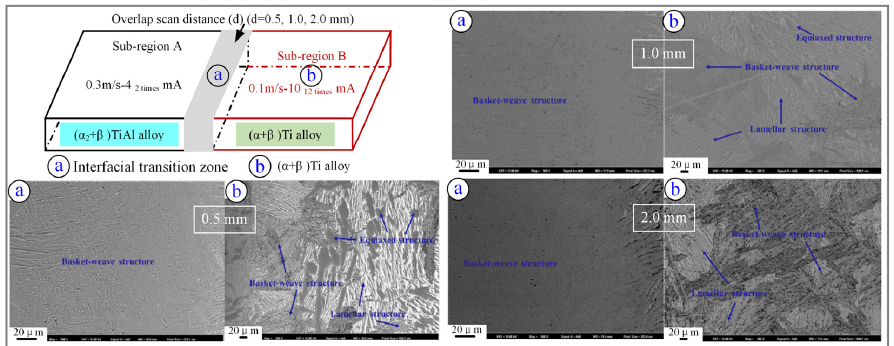
Figure 10. ( a ) Schematic of the secondary feeder in EB-PBF, ( b ) Schematic of Mo–Mo + TiC–Mo sandwich sample [64].